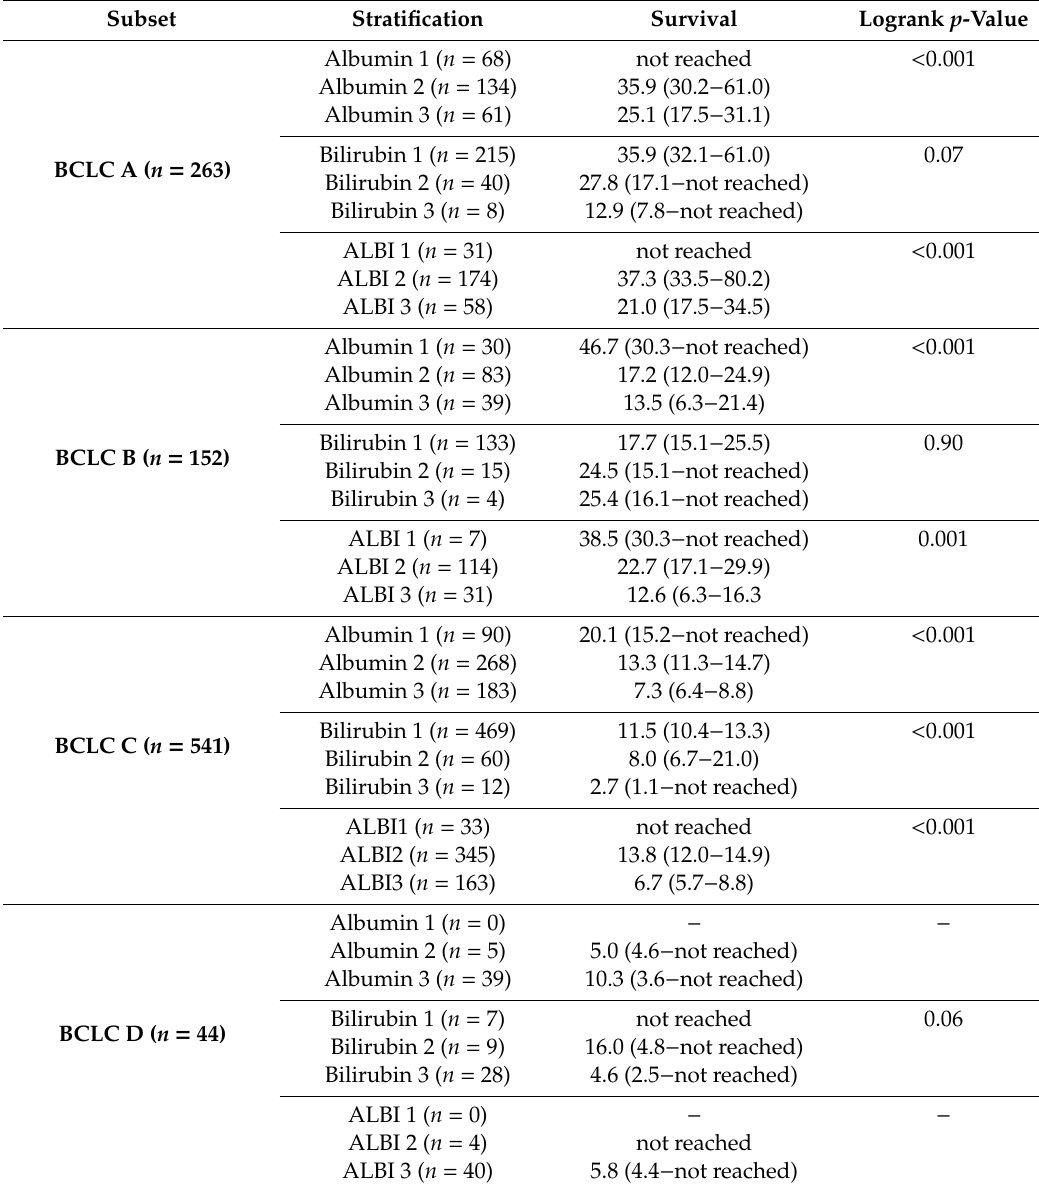
Table 5. Albumin and Bilirubin Survival within BCLC